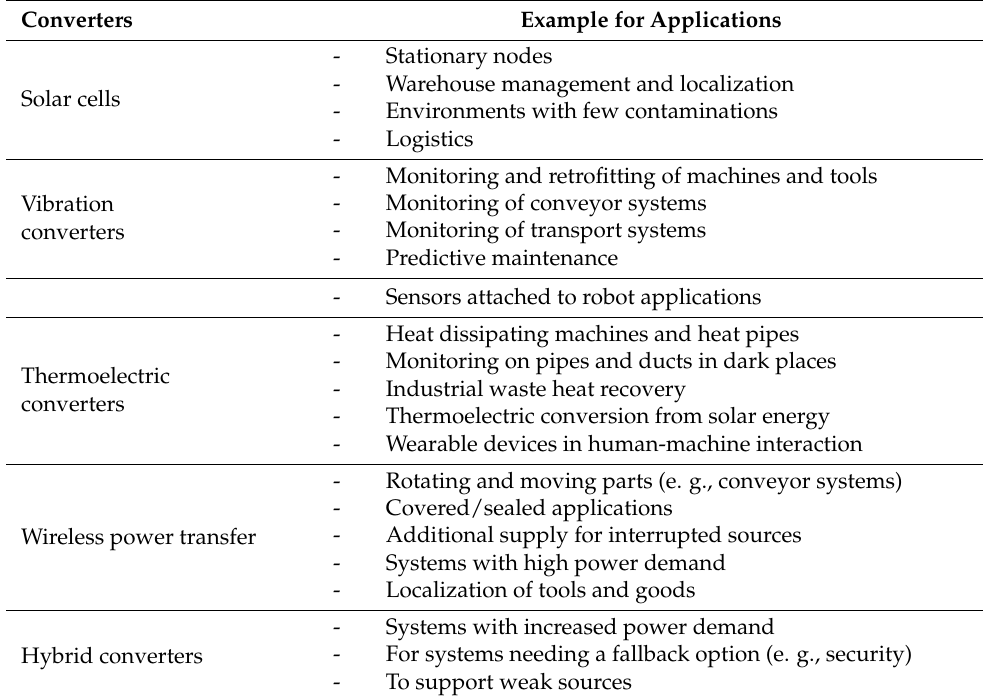
Table 1. Use of energy harvesting in WSNs for smart factories. Converters Example for